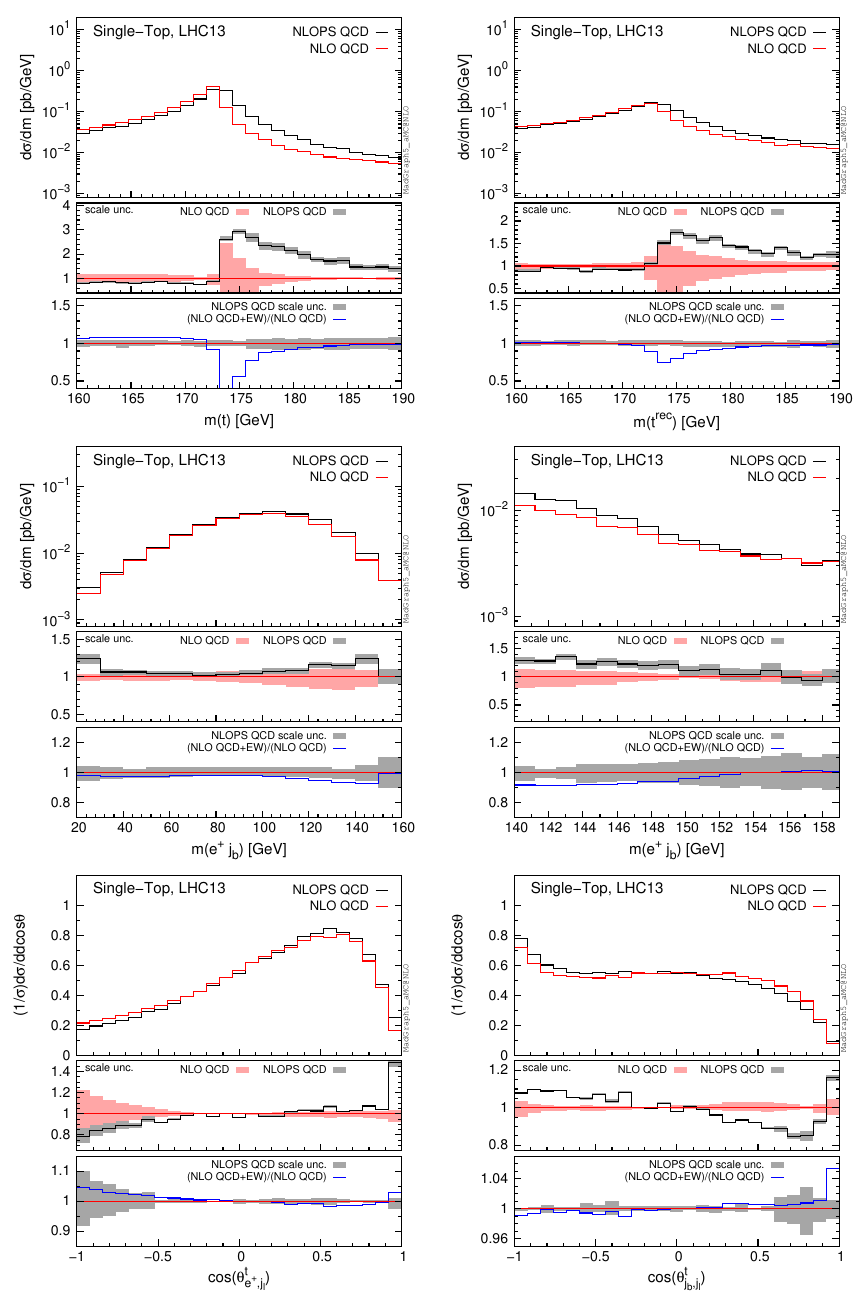
Figure 10 . Predictions at NLO(PS) QCD accuracy for the same observables considered in (cid:12)gure 3 for the Single-Top process. Note that the second inset shows the ratio of the NLO QCD+EW over the NLO QCD process, but with the relative uncertainty from the NLOPS QCD superimposed on the latter.